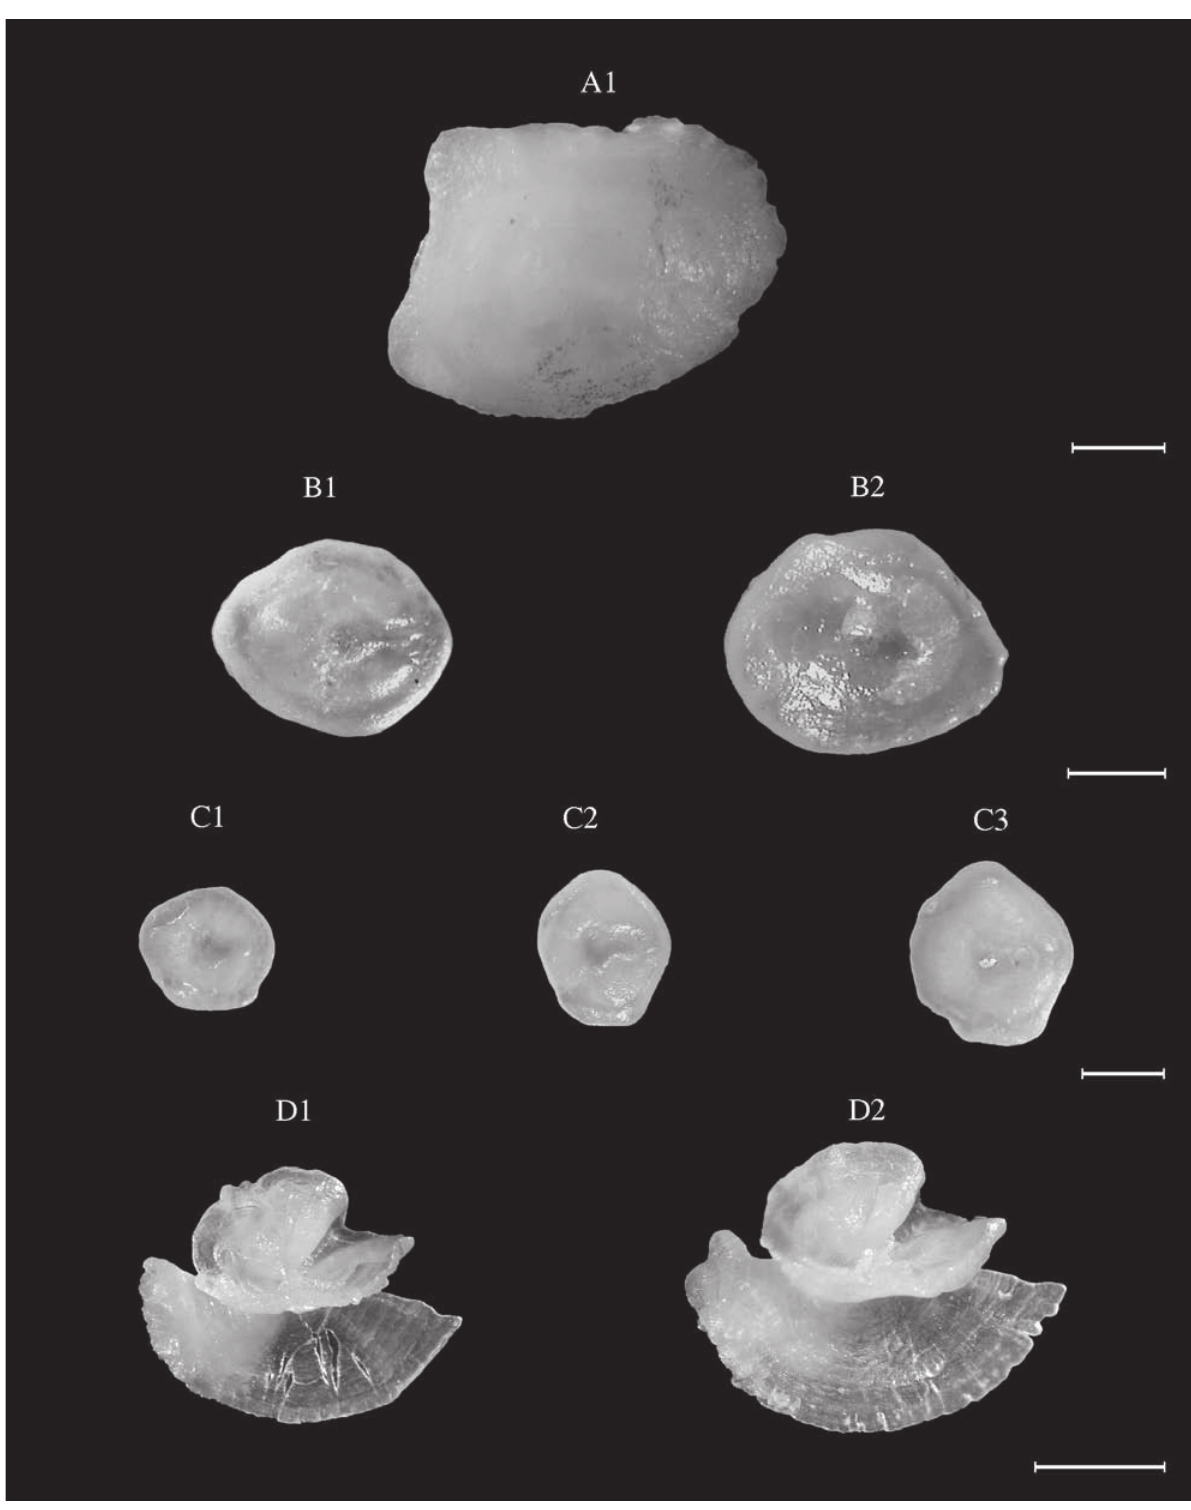
Fig. 95. – Cynoglossus senegalensis (CEA). TL: A1, 30.0 cm. Symphurus ligulatus (WM). TL: B1, 7.0 cm; B2, 8.5 cm. Symphurus nigrescens (WM). TL: C1, 8.5 cm; C2, 10.5 cm; C3, 11.5 cm. Balistes capriscus (NEA) . TL: D1, 27.5 cm; D2, 20.4 cm. Scale bar = 1